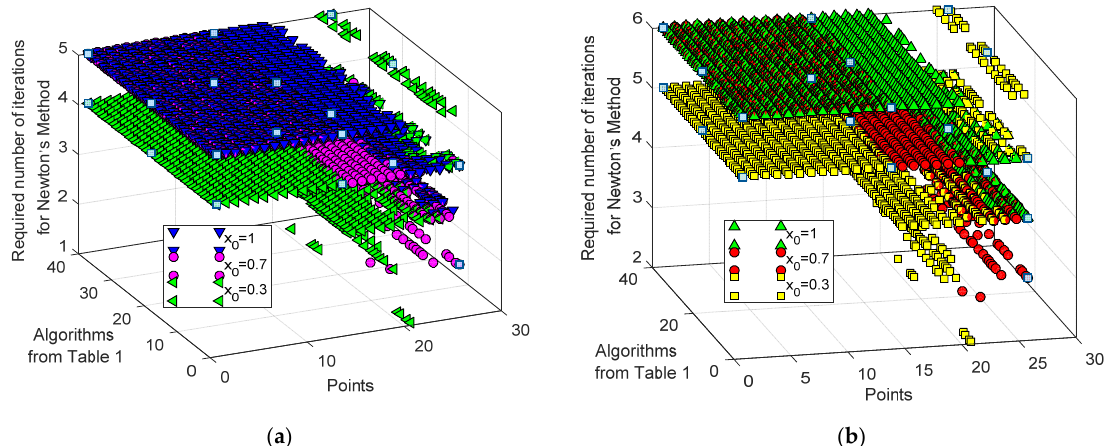
Figure 3. Required number of iterations for all voltage values with different stopping criteria using NM: ( a ) 10 − 5 ; ( b ) 10 − 10 .